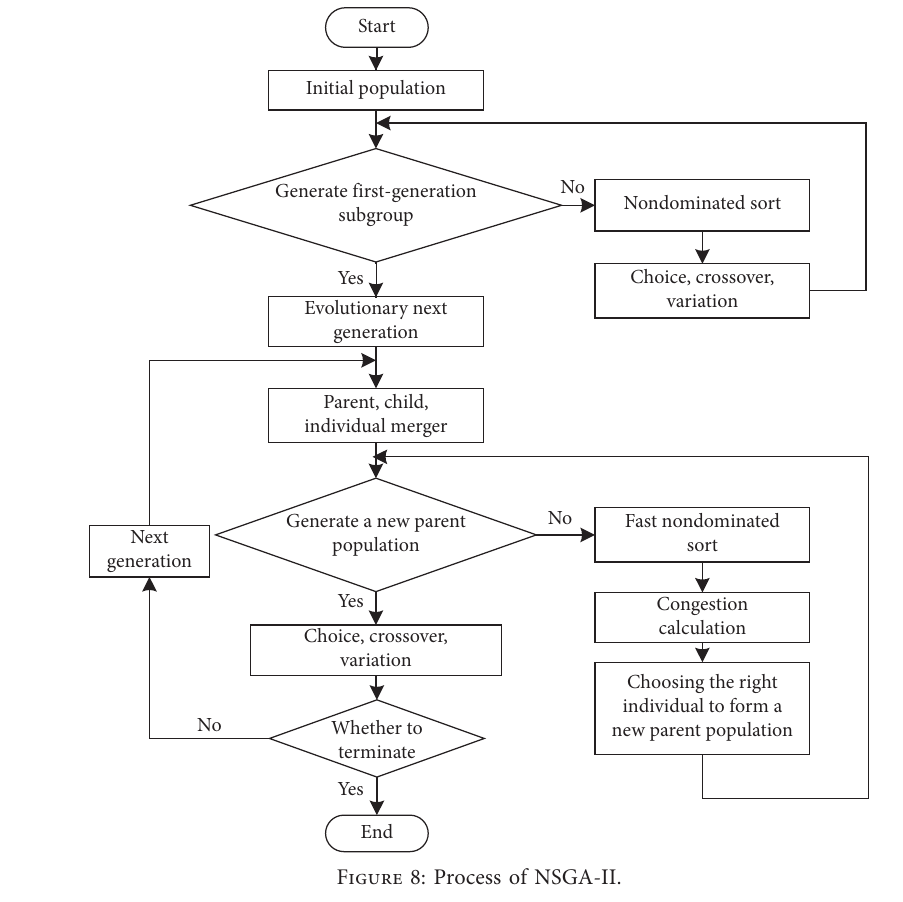
Figure 8: Process of NSGA-II.